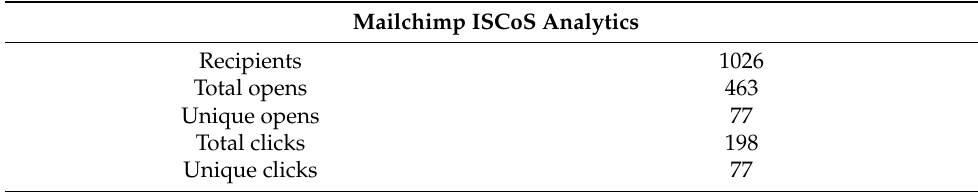
Table 4. Mailchimp ISCoS analytics from survey